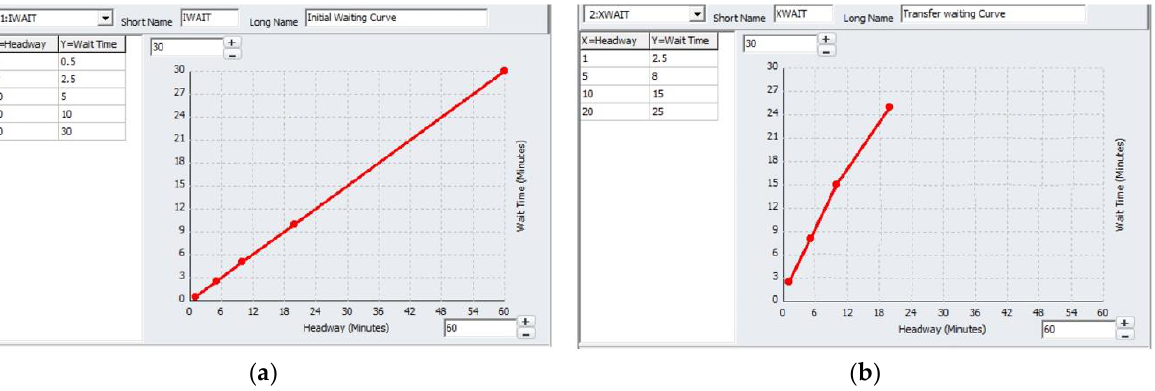
waiting Figure 2. ( a , b ) Initial waiting and transfer waiting for curves: ( a ) initial waiting curve; ( b ) transfer waiting curve .